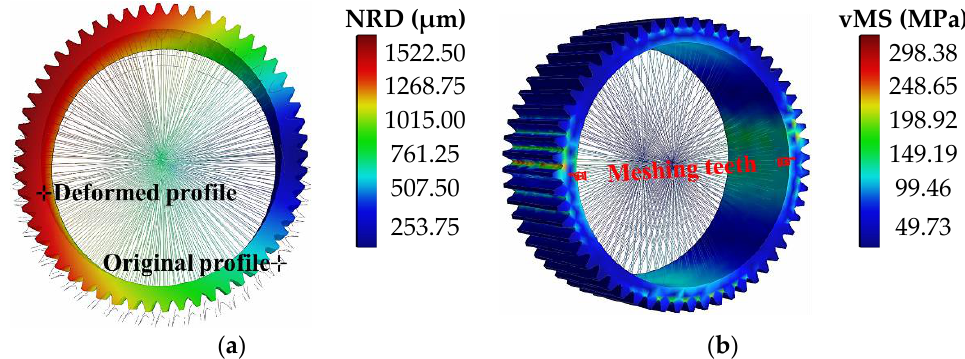
Figure 8. Mechanical analysis result of planet gear: ( a ) displacement nephogram; ( b ) stress nephogram.